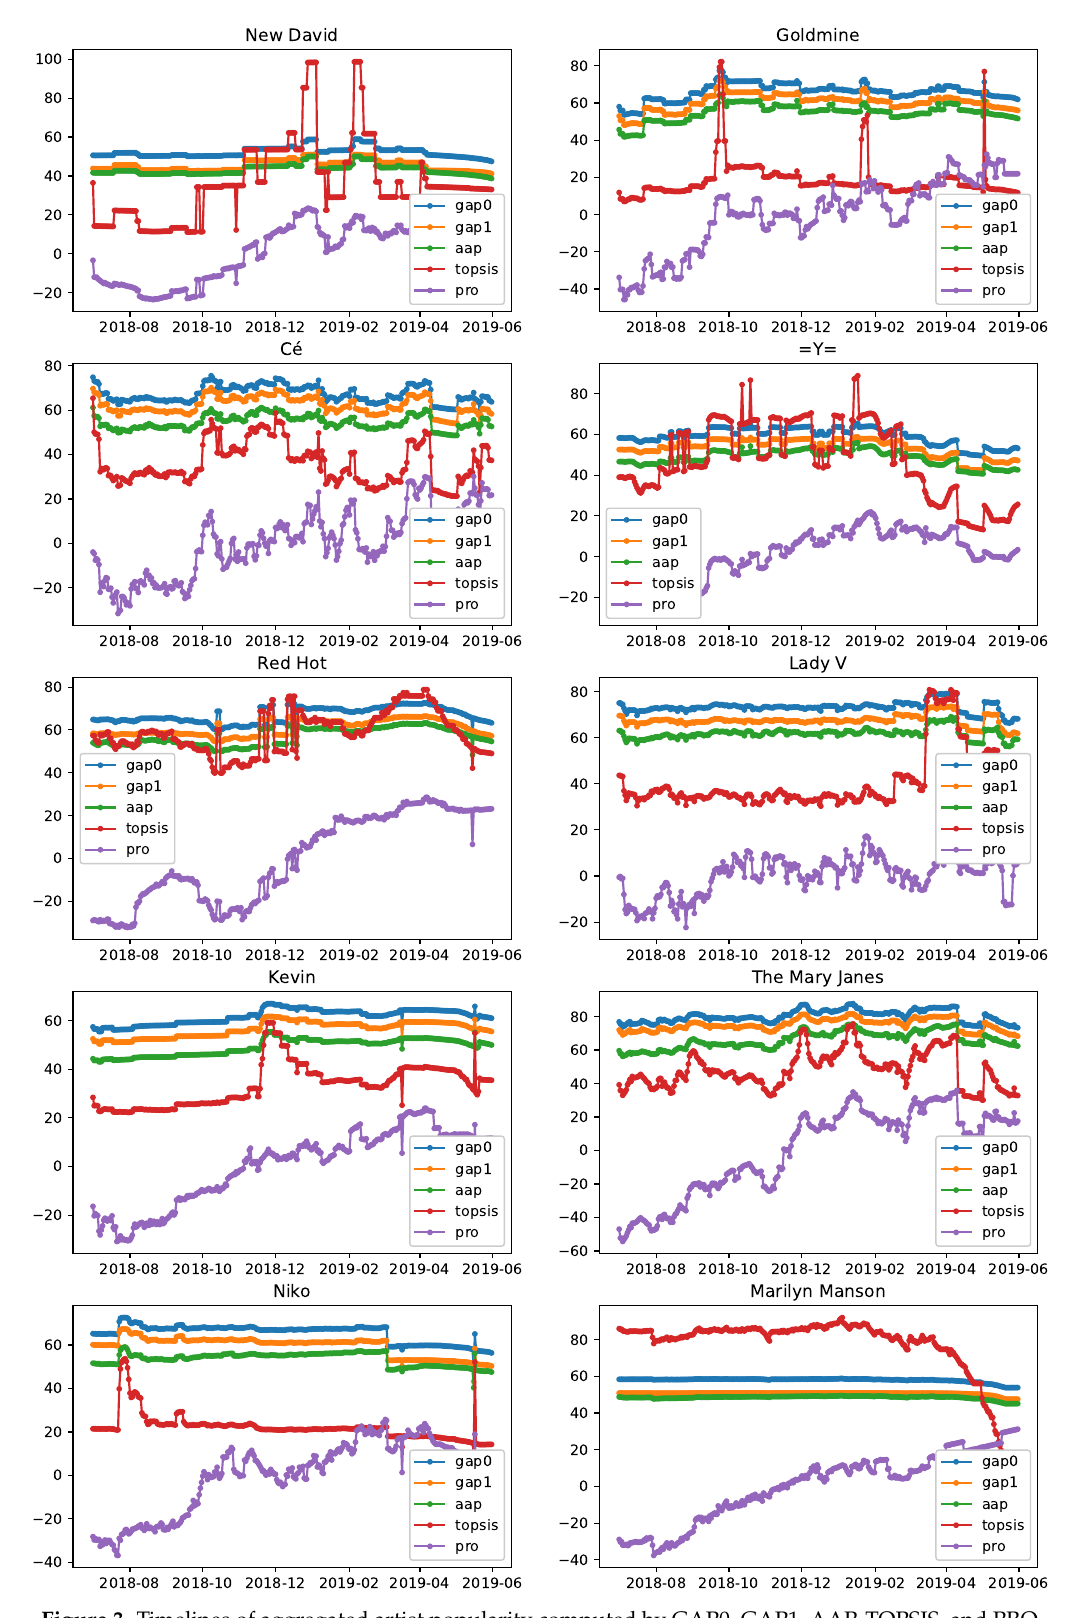
Figure 3. Timelines of aggregated artist popularity computed by GAP0, GAP1, AAP, TOPSIS, and PRO, for 10 artists with high discrepancy in their popularity as expressed by the monitored individual